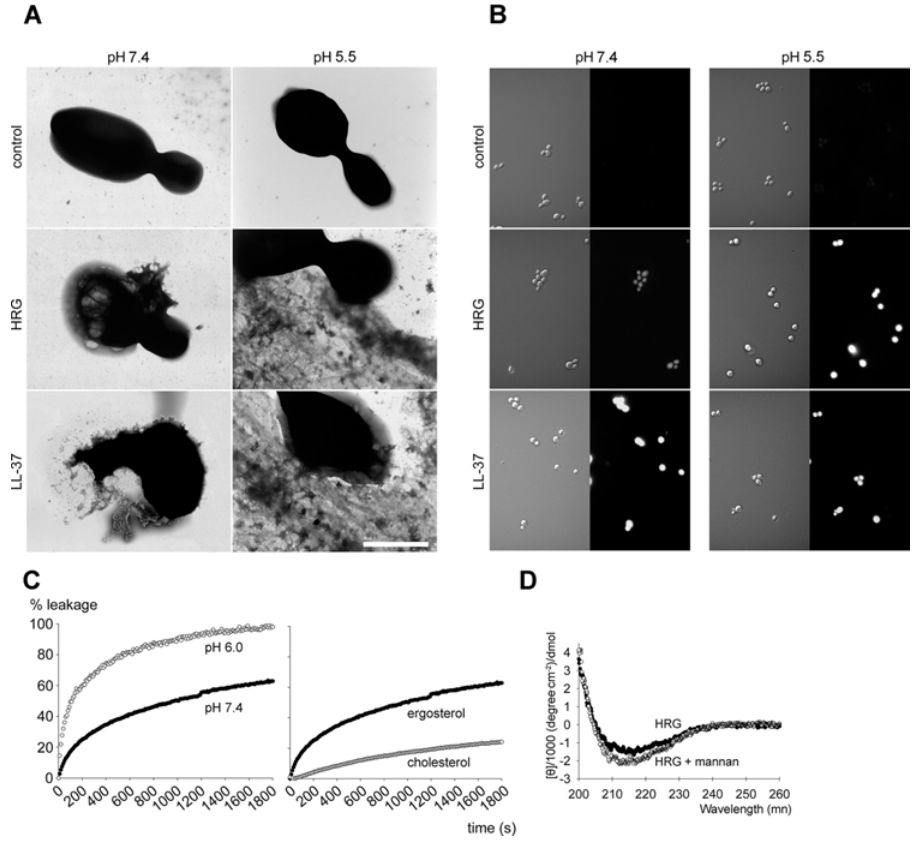
Figure 2. HRG induces membrane permeabilisation of Candida cells as well as liposomes. ( A ) Negative staining and electron microscopy analysis of C. parapsilosis exposed to HRG. C. parapsilosis ATCC 90018 were incubated in the absence of HRG in 10 mM Tris, pH 7.4 or 10 mM MES, pH 5.5. These fungi did not exhibit signs of membrane perturbations. In contrast, when treated with 10 m M HRG in 10 mM Tris, pH 7.4 or 10 mM MES, pH 5.5 membrane damage, blebbing and ejection of cytoplasmic components was observed. Fungi treated with 10 m M LL-37 was used as a positive control for membrane damage. The scale bar corresponds to 2 m m. ( B ) Fungal viability after incubation with HRG and LL-37. C. albicans ATCC 90028 were incubated with 10 m M HRG or LL-37 in either 10 mM Tris, pH 7.4 (left panel) or 10 mM MES, pH 5.5 (right panel). The left images in each row are Nomarski Differential Interference Contrast images, whereas the right images show FITC fluorescence of fungi. ( C ) Effects of 1 m M HRG on liposome permeability. Left panel. Increase in HRG-induced permeabilization of ergosterol-containing liposomes is detected at pH 6.0. Right panel. Increased HRG-induced lysis of (at pH 7.4) ergosterol containing liposomes. ( D ) CD spectroscopy of HRG under different conditions. CD spectra for 0.25 m M HRG in buffer and in presence of S. cerevisiae mannan are